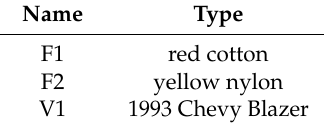
Table 1. Characteristics of the implanted target spectra in our synthetic data experiments.